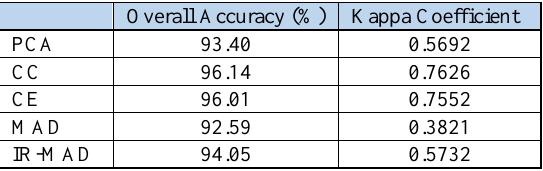
Table 2. The result of polarimetric CD based on TB